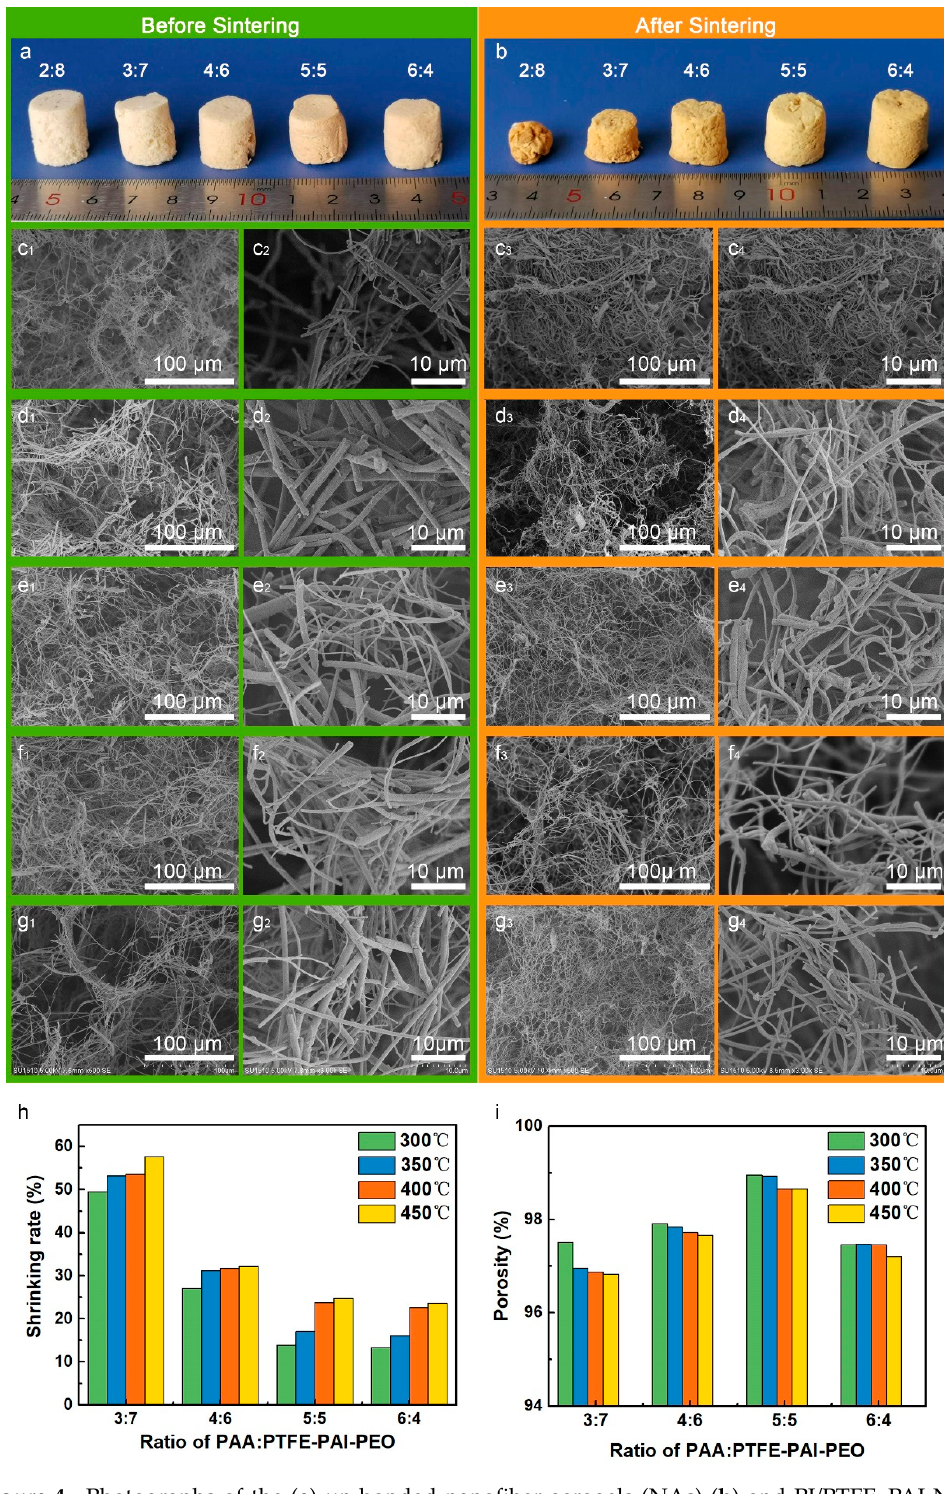
Figure 4. Photographs of the ( a ) un-bonded nanofiber aerogels (NAs) ( b ) and PI / PTFE–PAI NAs after sintering with di ff erent weight ratio of PAA:PTFE–PAI–PEO nanofibers. SEM images of NAs before and after sintering of di ff erent ratios of PAA: PTFE–PAI@PEO nanofiber: ( c 1 – c 4 ), 2:8; ( d 1 – d 4 ), 3:7; ( e 1 – e 4 ), 4:6; ( f 1 – f 4 ), 5:5; ( g 1 – g 4 ), 6:4. The fiber content was 1.0%, and sintering was conducted at 400 ◦ C for 30 min; ( h ) shrinkage and ( i ) porosity of di ff erent PI / PTFE–PAI NAs after sintering at di ff erent temperature.